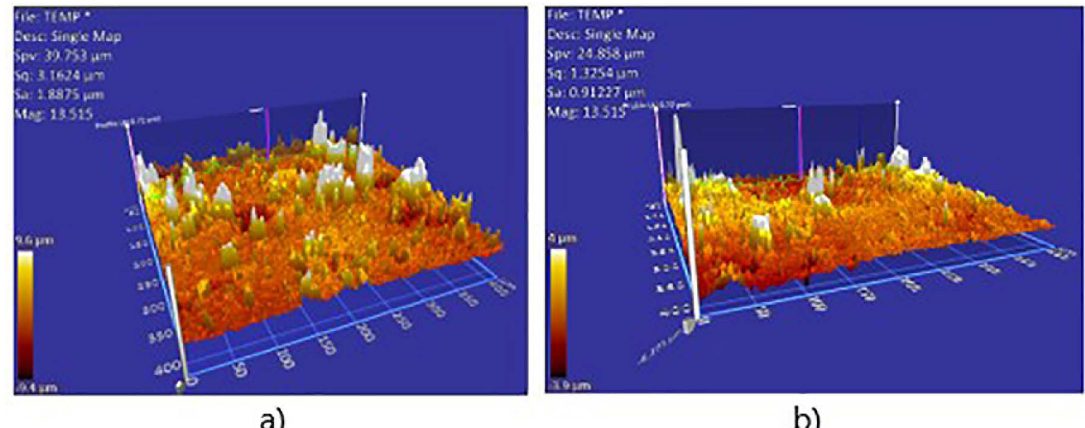
Figure 4. The optical profiles of the W5%Lig sample after sintering a) at 90 ºC and b) 100